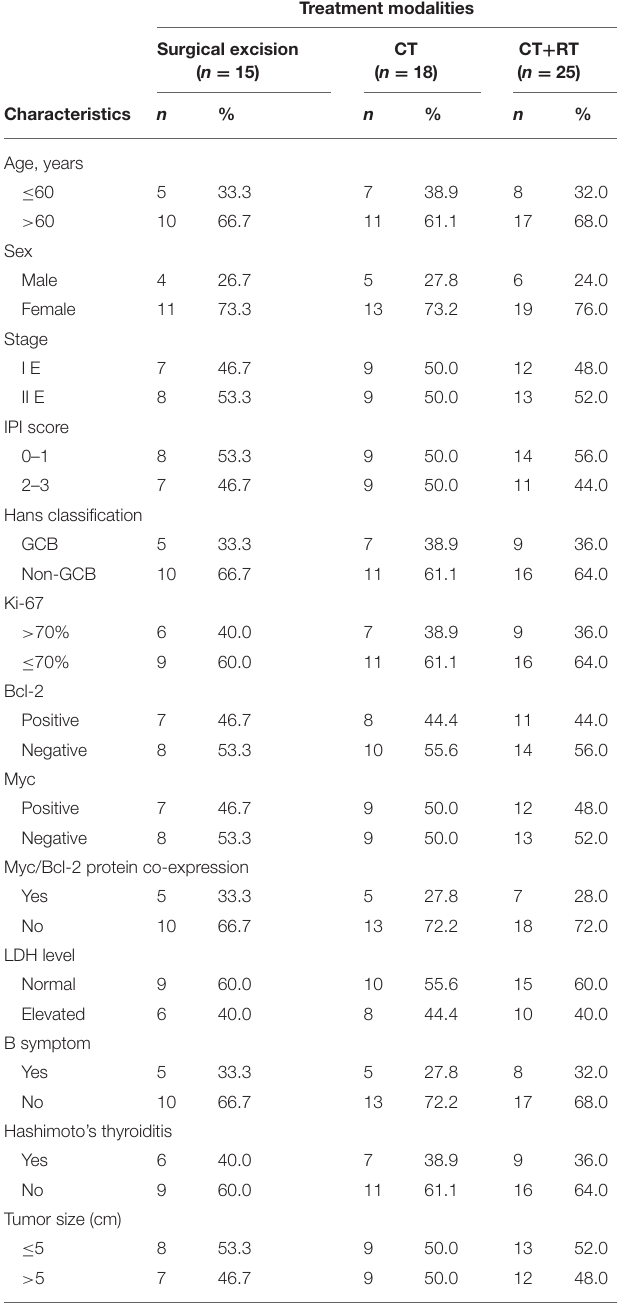
TABLE 2 | The baseline characteristics of the patients treated with different treatment modalities. Treatment